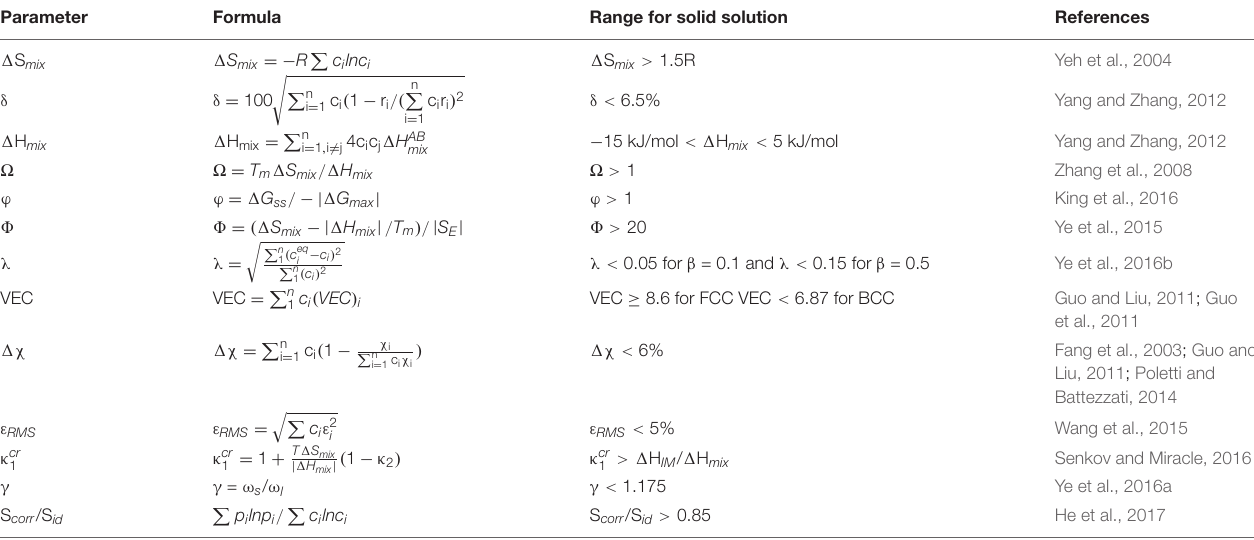
TABLE 1 | The thermo-physical parameters for HEAs’ phase selection. Parameter Formula Range for solid solution